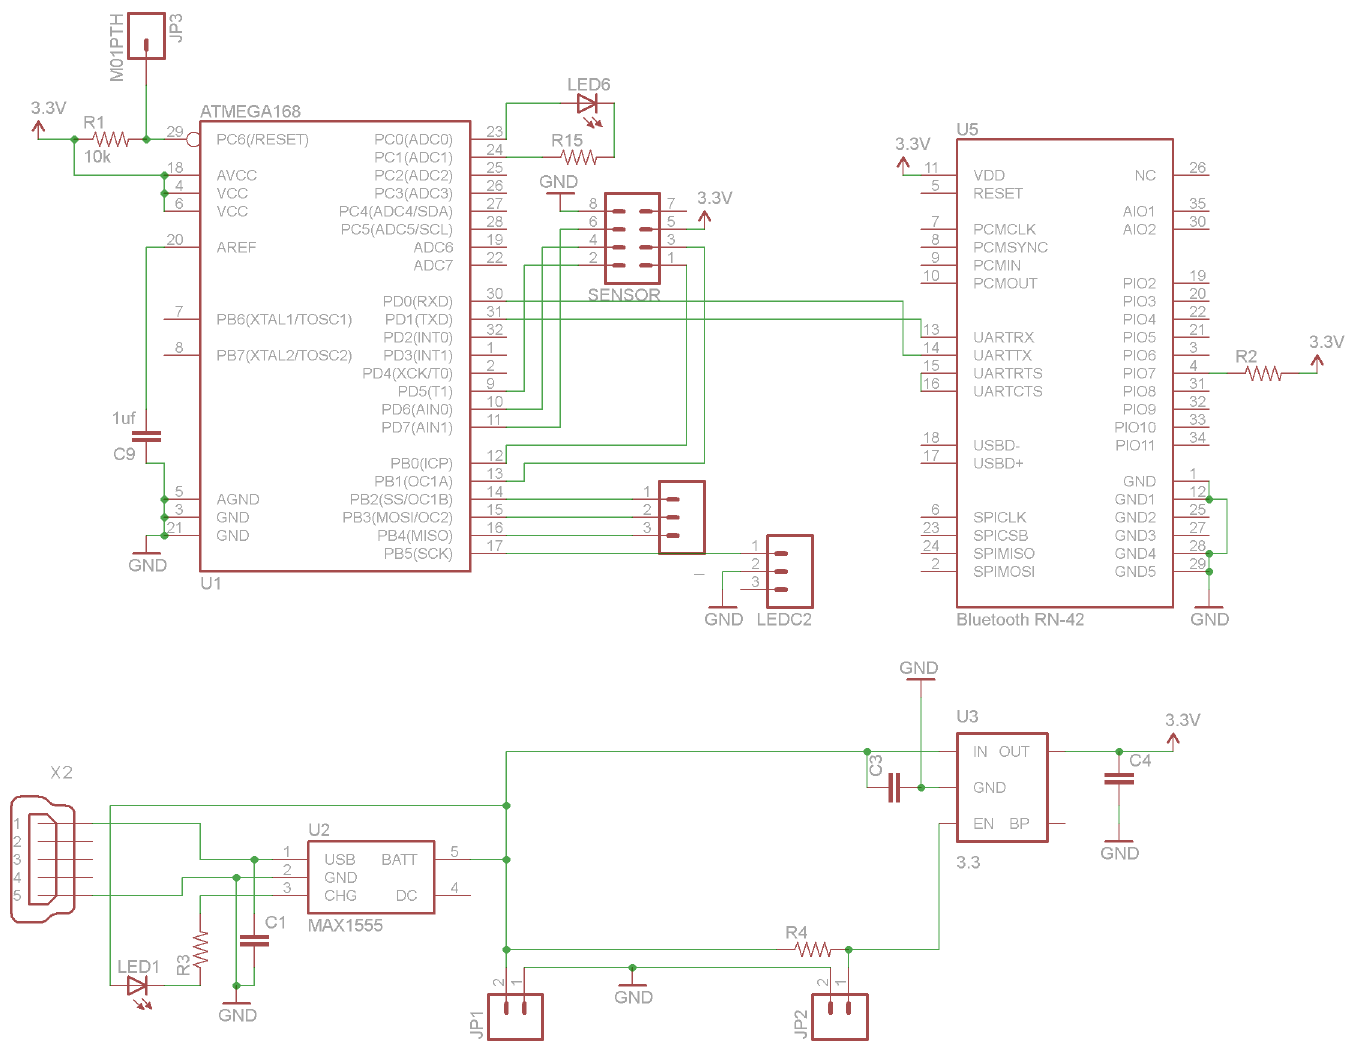
Fig 1. Schematic for open-source electronics 1) the main ATMega board, 2) Bluetooth module, and 3) Power.